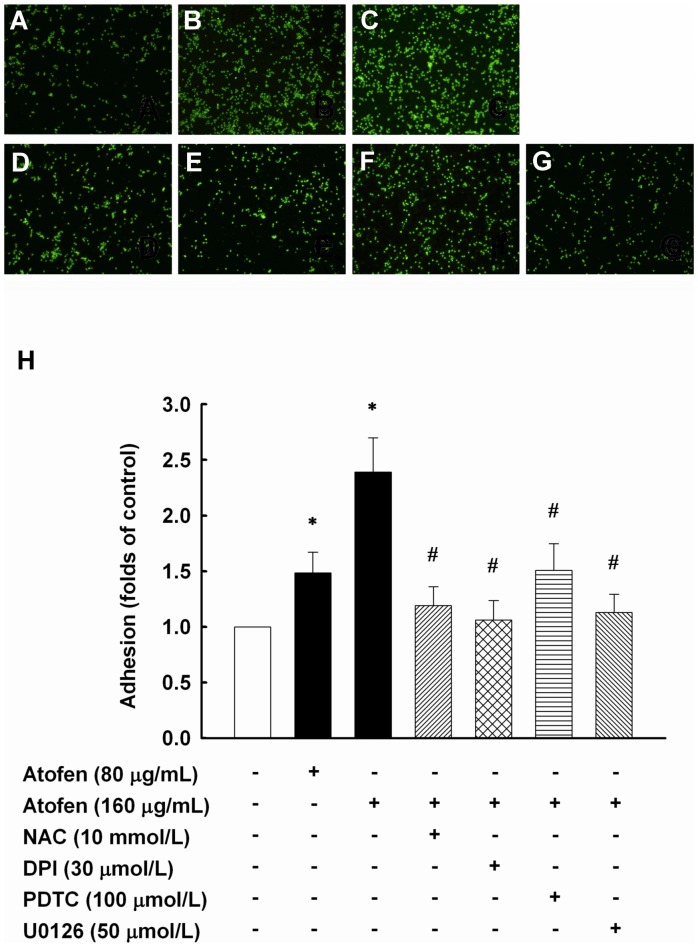
Iron enhanced adhesiveness of human MNCs to HAECs.HAECs were treated with ferric chloride hexahydrate (Atofen) with or without NAC (100 mmol/L), DPI (30 µmol/L), PDTC (100 µmol/L), and U0126 (50 µmol/L) for 4 hours. In upper panel, HAECs were unstimulated (control) (A), or stimulated by 80 µg/mL of Atofen alone (B), by 160 µg/mL of Atofen alone (C), and by co-treatment with 160 µg/mL of Atofen and NAC (D), DPI (E), PDTC (F), U0126 (G), respectively. Cell adherence was expressed as the fold difference over the untreated control. Values are expressed as mean ± SEM. *P<0.05 compared with baseline. #
P<0.05 compared with 160 µg/mL Atofen for 4 h. Abbreviations: DPI, diphenyleneiodonium; HAECs, human aortic endothelial cells; NAC, N-acetylcysteine; PDTC, pyrrolidine dithiocarbamate.